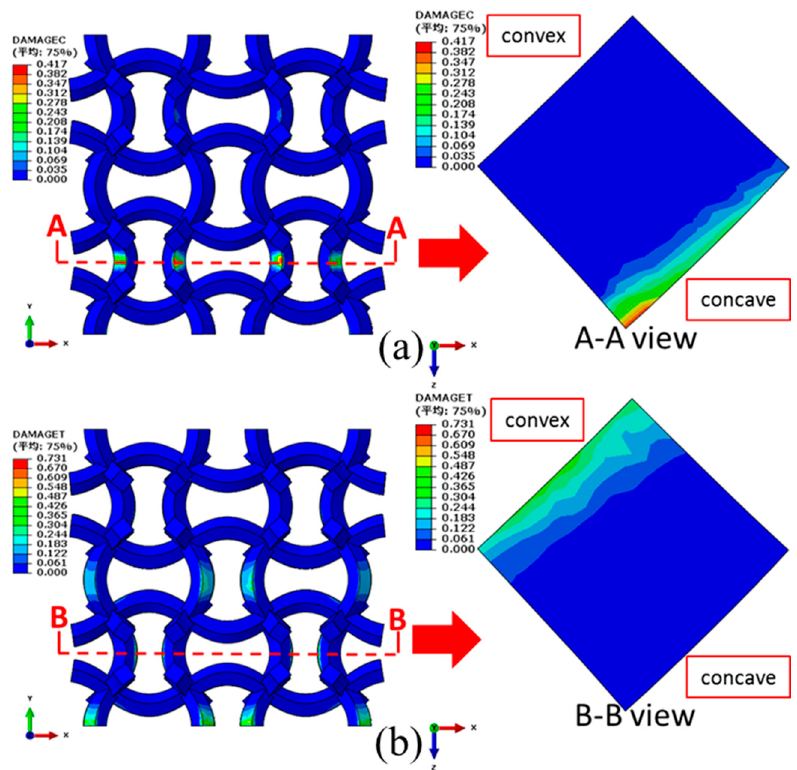
Figure 14. Damage distributions of the CCF2 under the compressive displacement of 1.5 mm (uniaxial strain of 7.5%) in the y direction: ( a ) compressive damages; ( b ) tensile damages.